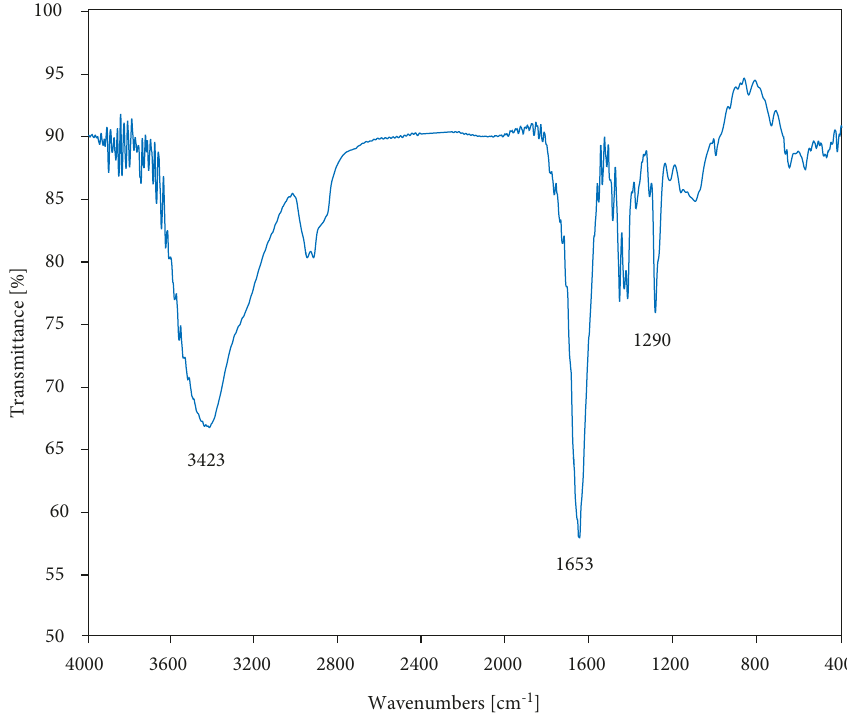
Figure 1: Fourier transform infrared spectroscopy (FTIR) spectra of selenium nanoparticles.